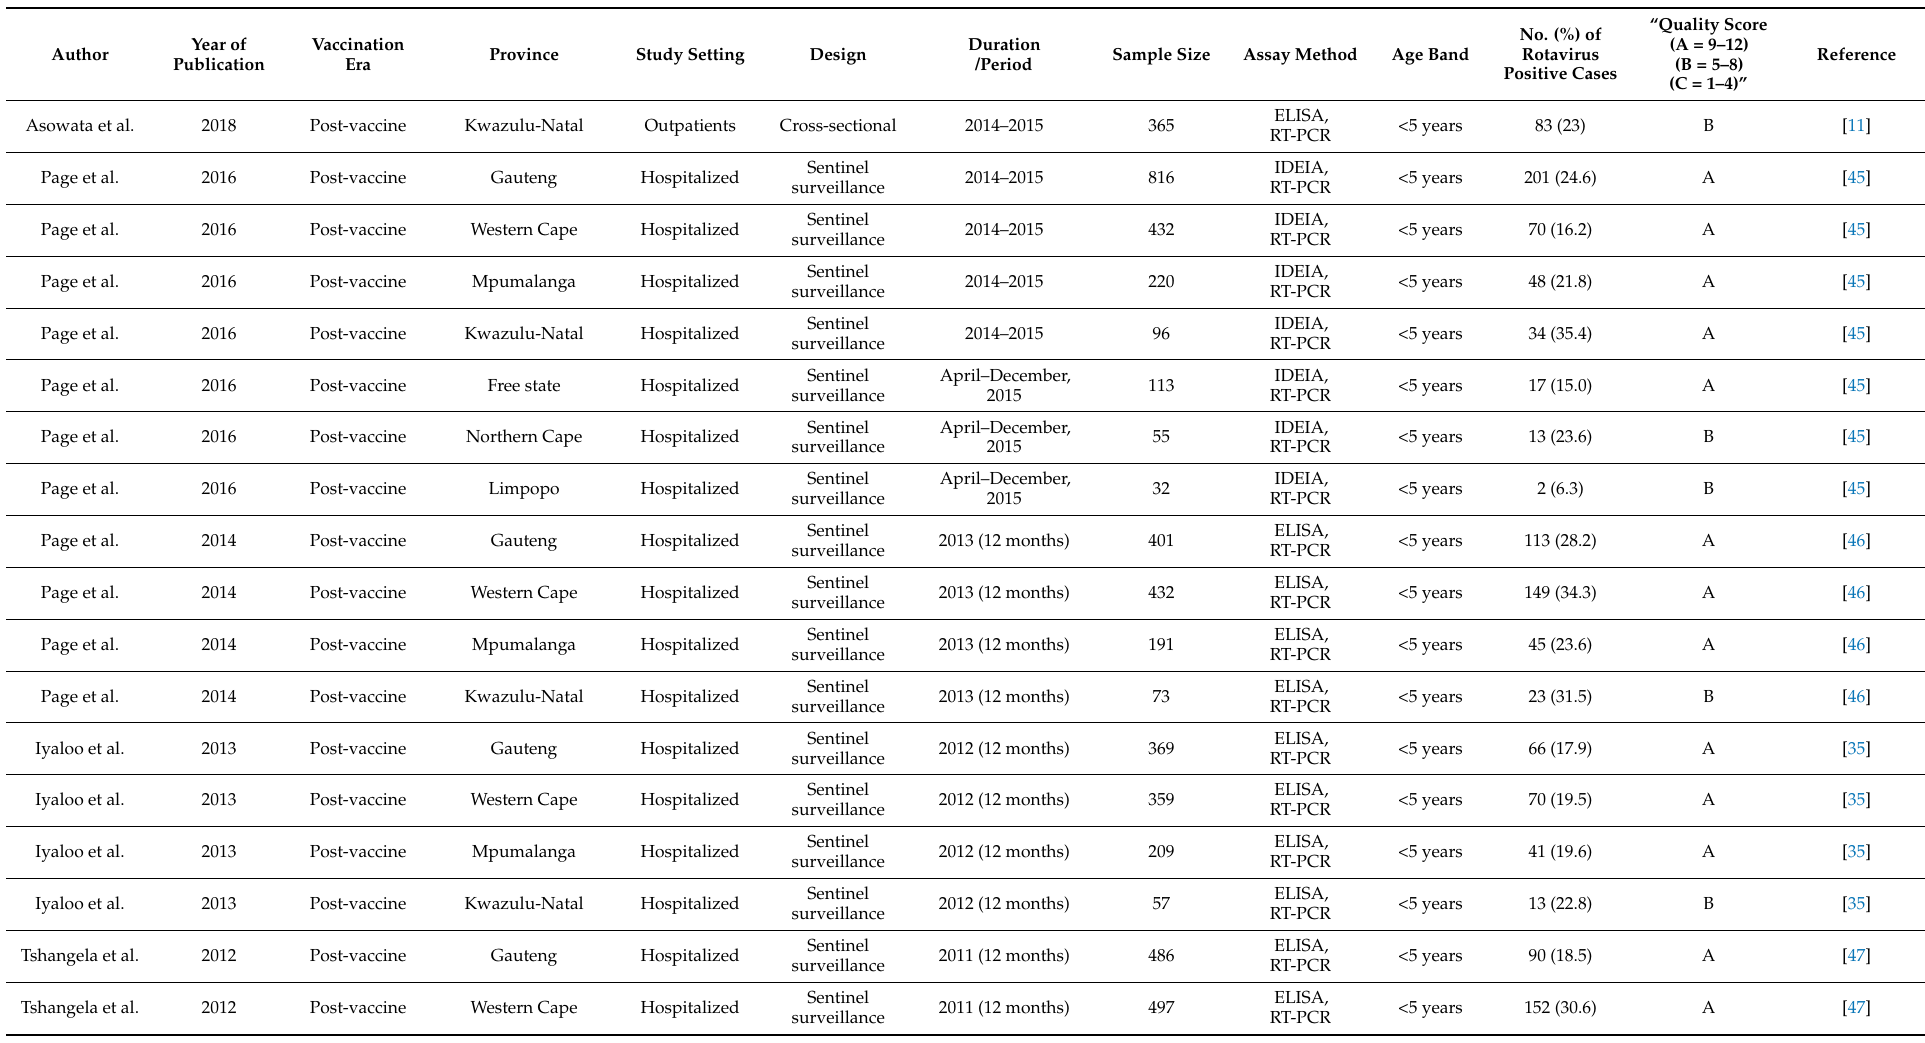
Table 1. Descriptive characteristics of included studies in South